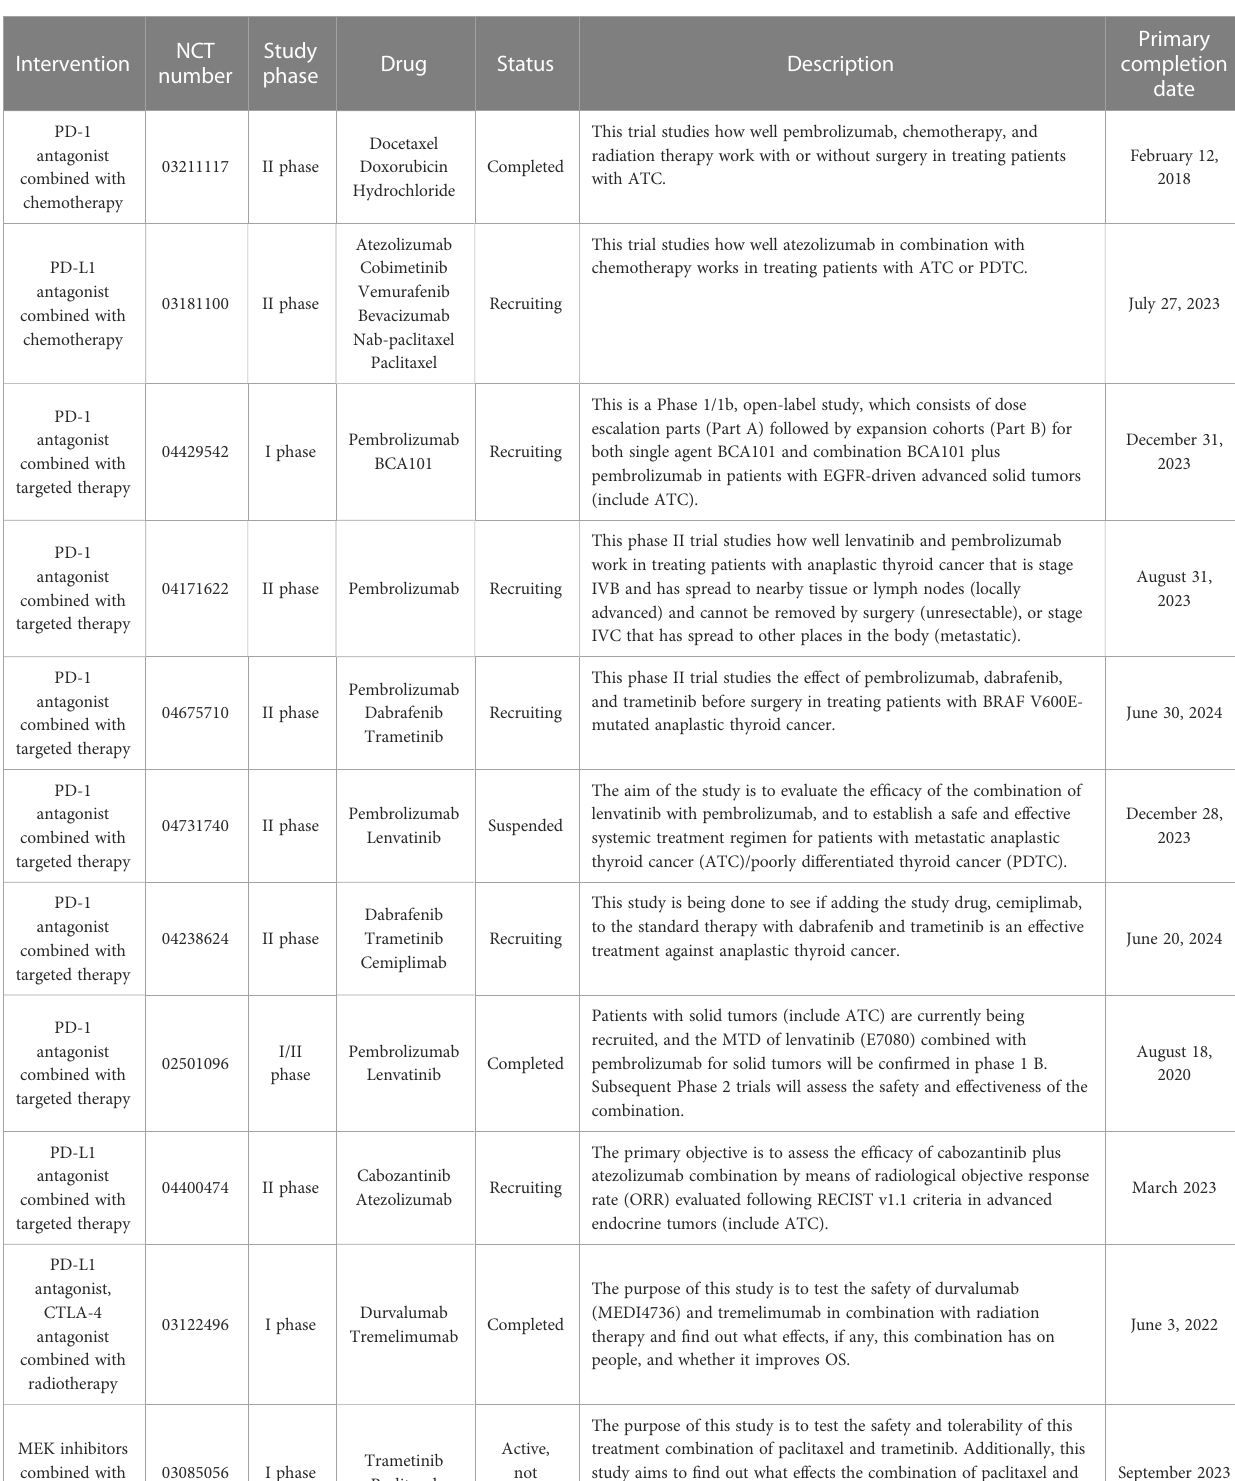
TABLE 3 Clinical trials of combination strategies for